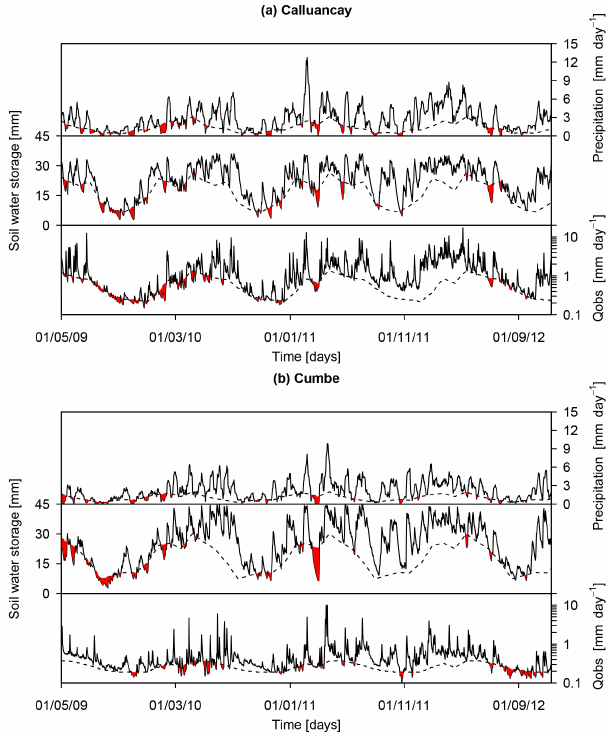
Figure 6. Drought propagation for each experimental catchment. The discharge corresponds to the observed data. The soil water stor- age is the storage simulated by the PDM